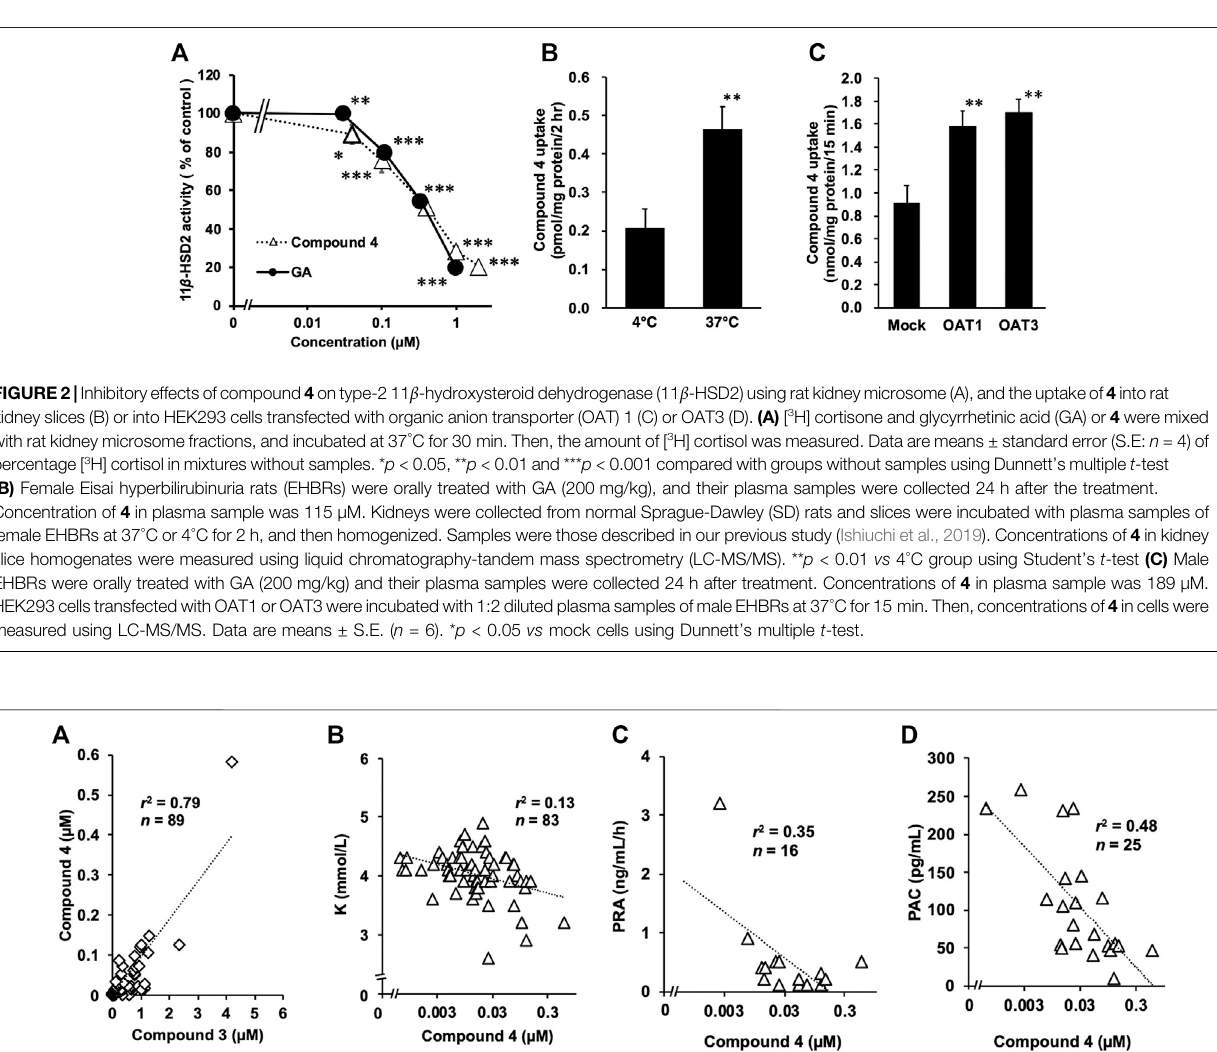
( Figure 2 ) and the results of the uptake study using OAT1-and OAT3-induced cells ( Figure 2C ) were performed using a one- way analysis of variance (ANOVA), followed by Dunnett ’ s multiple t -test using PASW Statistics (version 18, SPSS; IBM, Armonk, NY, United States). Statistical analysis of the uptake study using rat kidney slices ( Figure 2B ) was performed using the Student ’ s t -test with the Microsoft Excel ® . The calibrated line and the regression formula in Figures 3 , 4D were calculated by the linear least-squares method along with Pearson ’ s product moment correlation coef fi cients using the Microsoft Excel ® . A probability value of less than 0.05 was considered statistically signi fi cant.